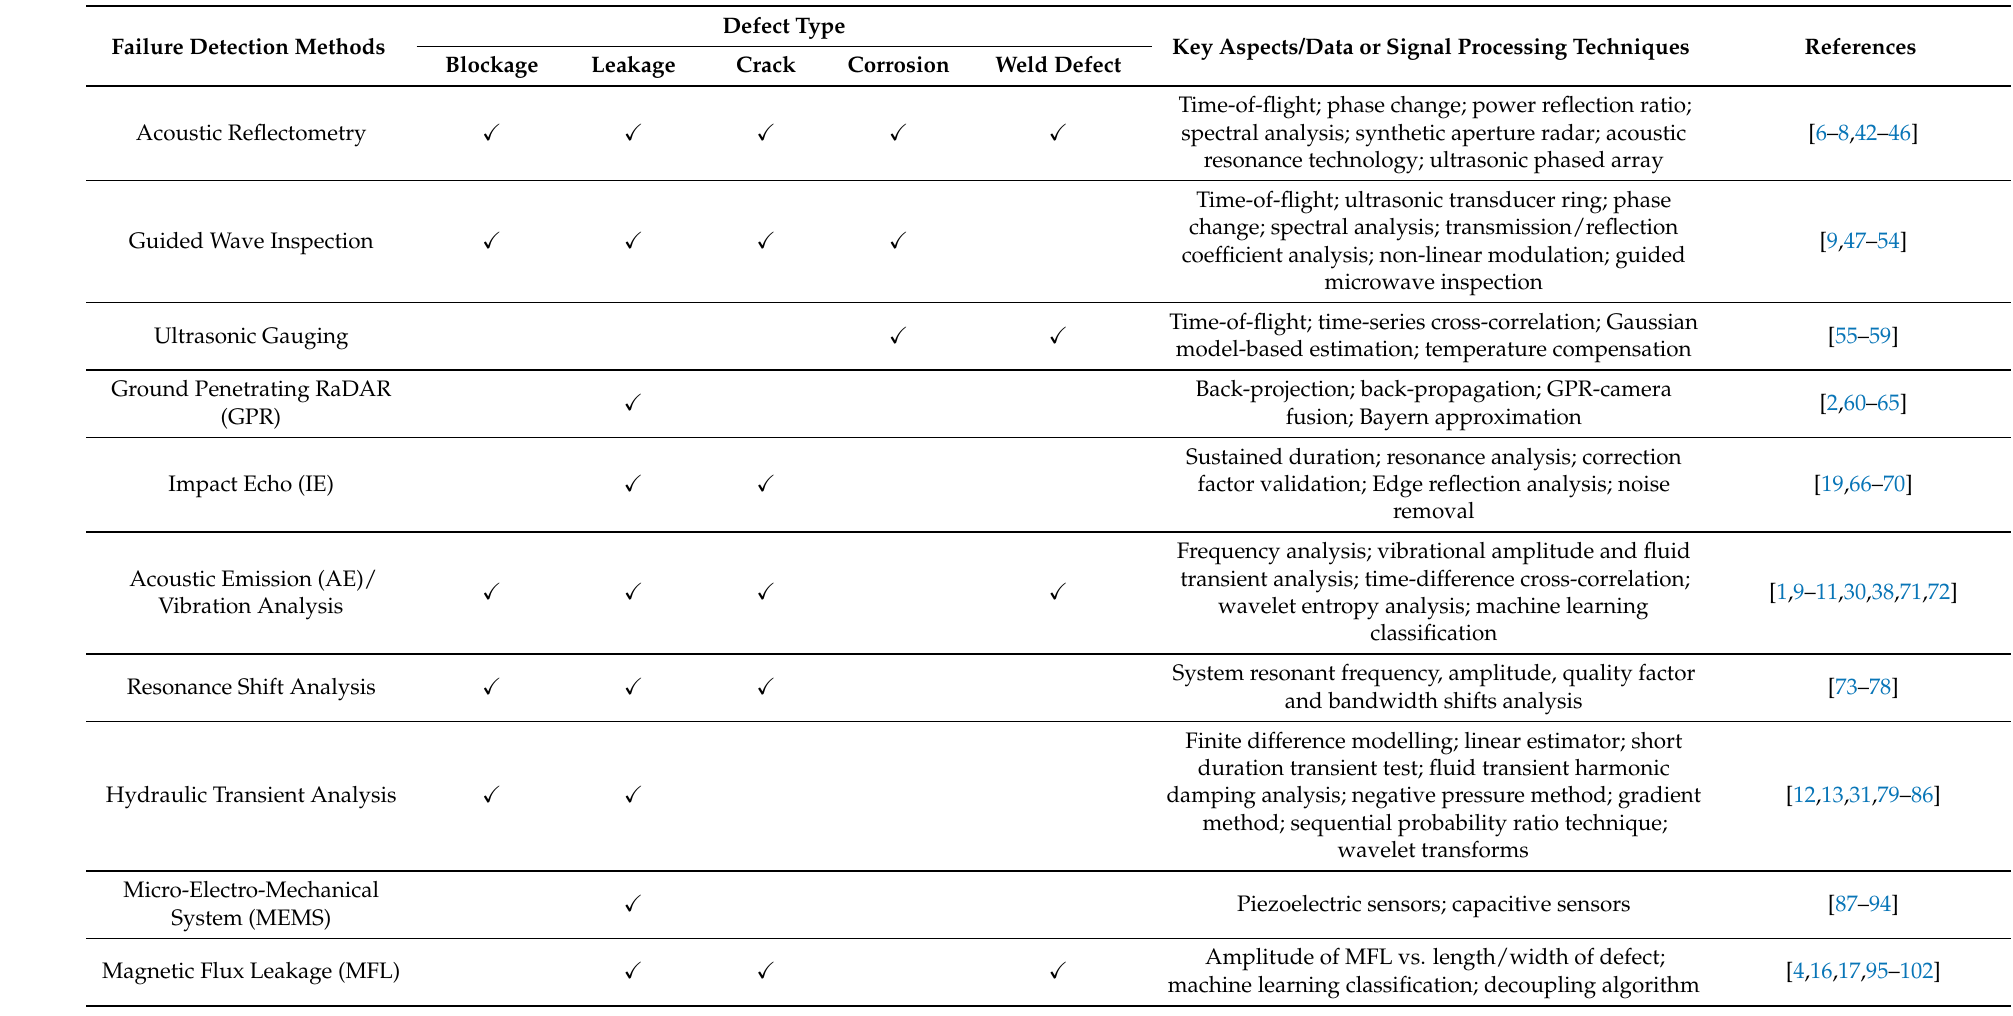
Table 1. The suitability of existing non-destructive methods for the detection of different pipeline